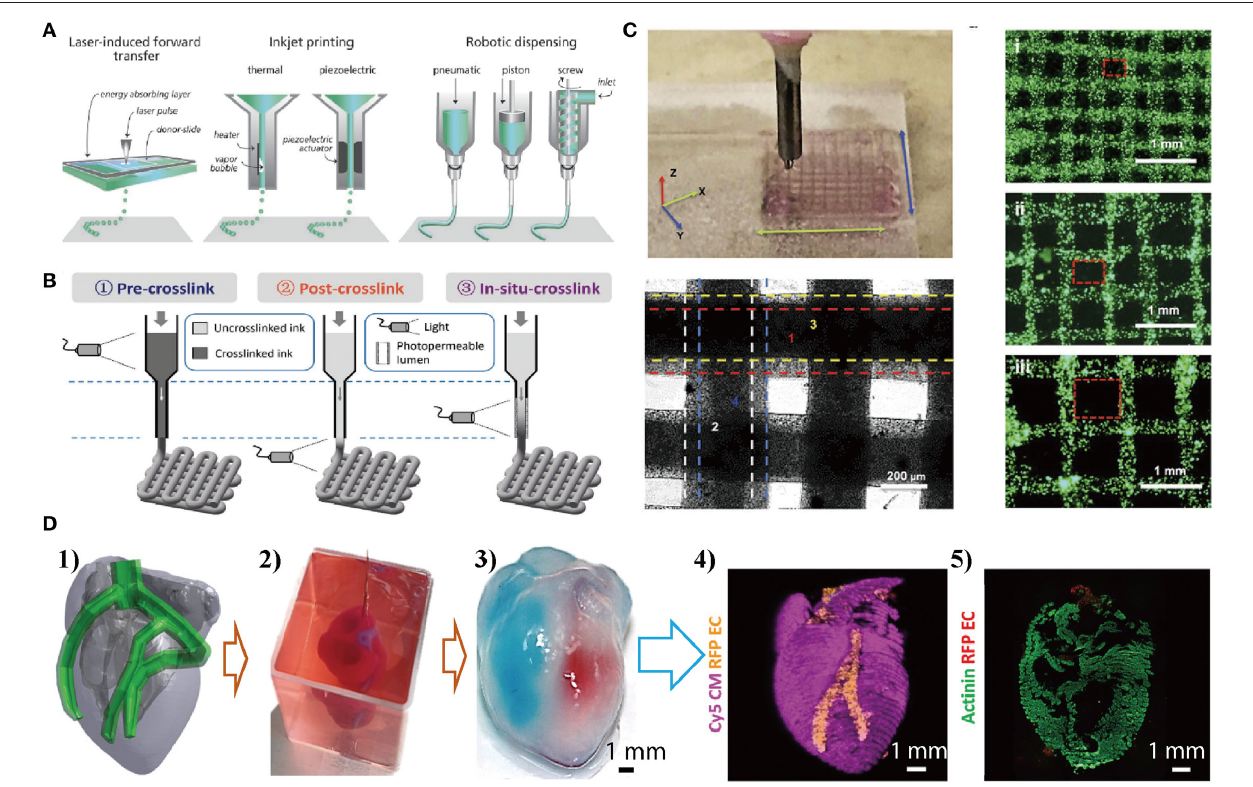
FIGURE 2 | Bio-printing cell-material composites layer-by-layer to produce mini-organs with complex structures. (A) Cell-laden composite hydrogels are created by applying laser light (laser-induced forward transfer) or by extrusion (inkjet printing with or without robotic dispensing). Reproduced with the permission from WILEY-VCH ( Malda et al., 2013). (B) Light-induced crosslinking strategies for the bioprinting of photocrosslinkable bioinks. Reproduced with permission from WILEY-VCH (Ouyang et al., 2017). (C) Bio-printed simple 3D constructs using gold/GelMA composite bioinks, with different grid architecture. Reproduced with the permission from WILEY-VCH (Zhu et al., 2017). (D) Bio-printed 3D heart models with two types of cells: (1) The human heart CAD model. (2) A printed heart within a support bath. (3) After extraction, the left and right ventricles were injected with red and blue dyes, respectively, demarcating the hollow chambers and presence of the septum. (4) 3D confocal laser microscopy image of the printed heart (cardiomyocytes in pink, endothelial cells in orange). (5) Cross-section of the heart immunostained for sarcomeric actinin (green). Reproduced under the CC BY Creative Commons Attribution 4.0 International License ( Noor et al.,